Question: In one sentence, what is this figure communicating?
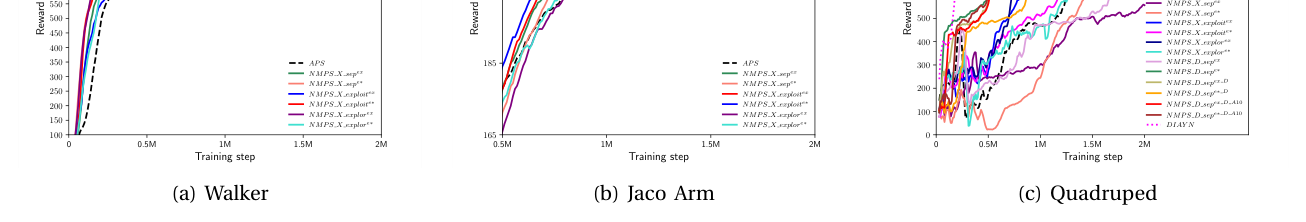
Answer: The comparison result of fine-tuning of all NMPS_X s of NMPS and APS on Walker (a) and Jaco Arm (b, smoothed line) and most NMPS variants and APS on Quadruped (c) by using the intrinsic reward of APS or DIAYN for Explor of NMPS.